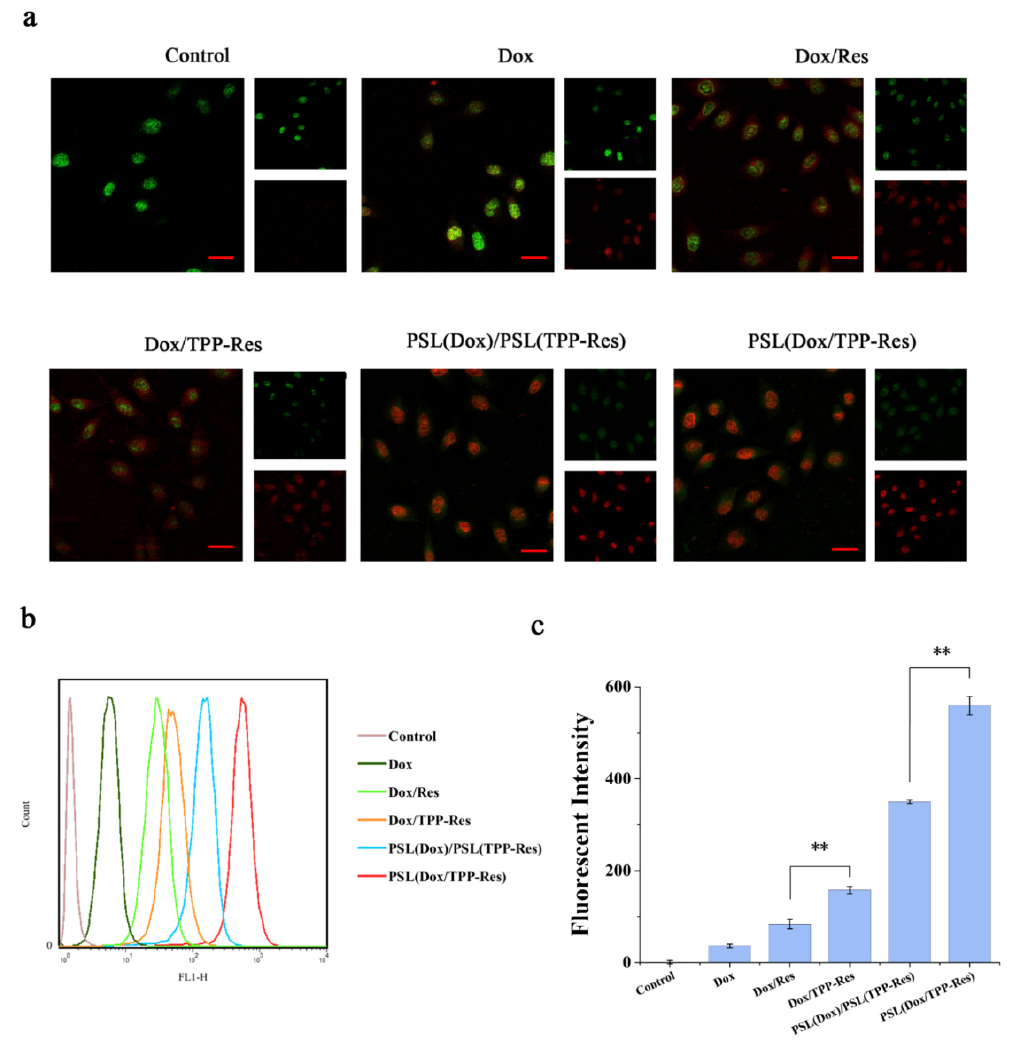
Figure 5. ( a ) Fluorescence microscopy images of CSLCs incubated with different formulations (Red: DOX; Green: CSLCs labeled with anti-CD44-FITC). ( b ) and ( c ) Flow cytometry measurements of the intracellular uptake of Dox in CSLCs treated with different formulations. Data were expressed as mean ± SD (n = 3), ** P < 0.01 compared with the control group. Scale bars represent 50 μ m.